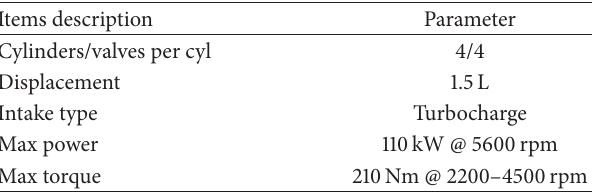
Table 1: Test engine specifications.